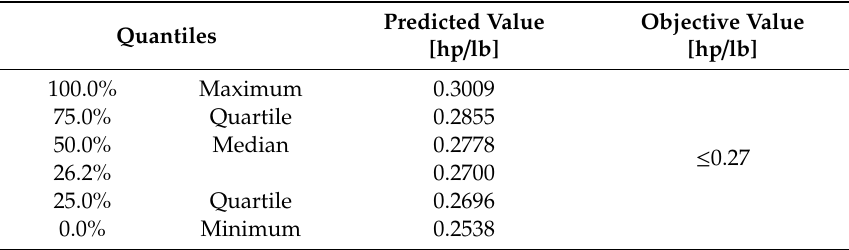
Table 18. Horsepower to weight ratio (P / W) percentile.